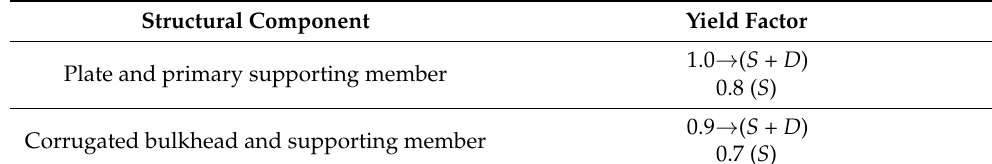
Table 1. Maximum permissible stress according to members.